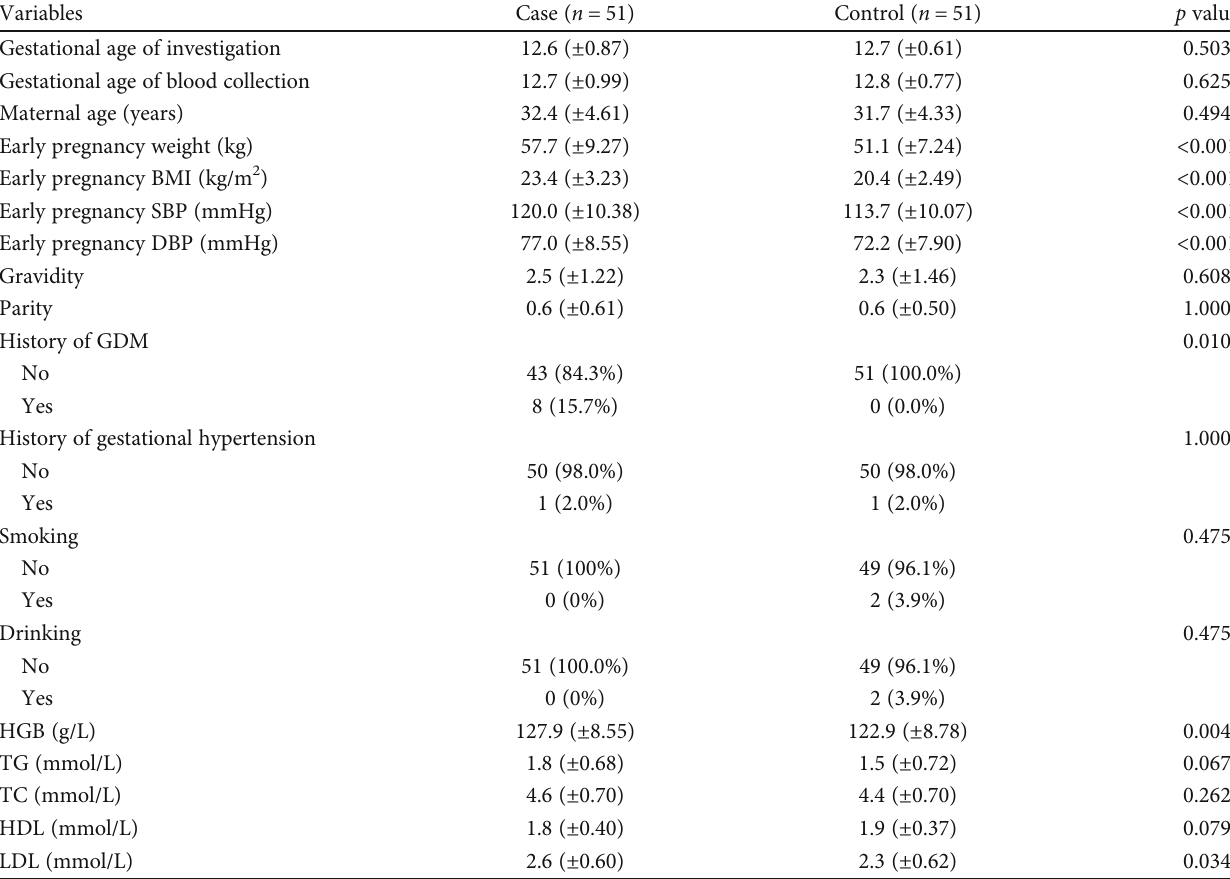
Table 1: Baseline characteristics and clinical information in the case and control